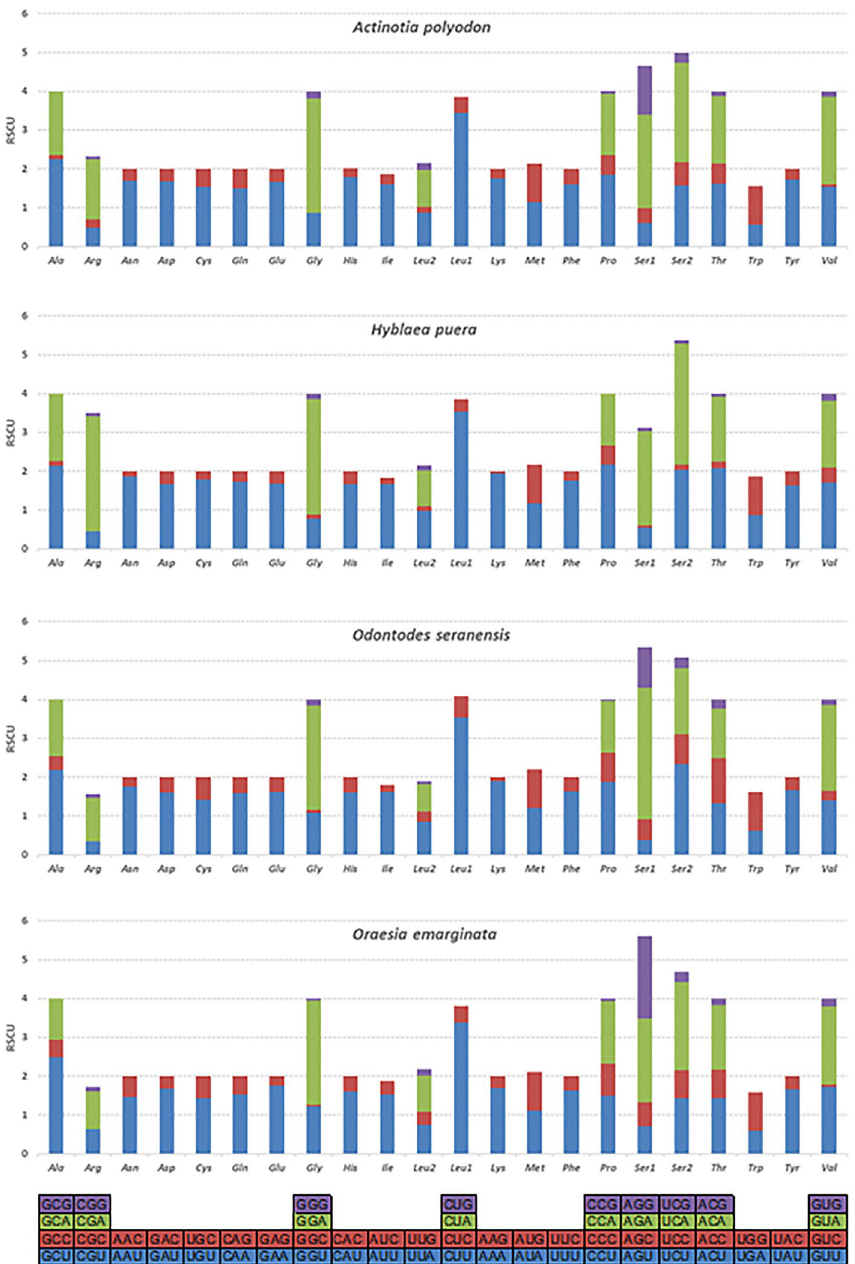
Figure 2. Relative Synonymous Codon Usage (RSCU) in Noctuoidea PCGs. The species name represents the superfamilies Noctuoidea & Hyblaeoidea. RSCU of Actinotia polyodon, RSCU of Odontodes seranensis, RSCU of Oraesia emarginata and RSCU of Hyblaea